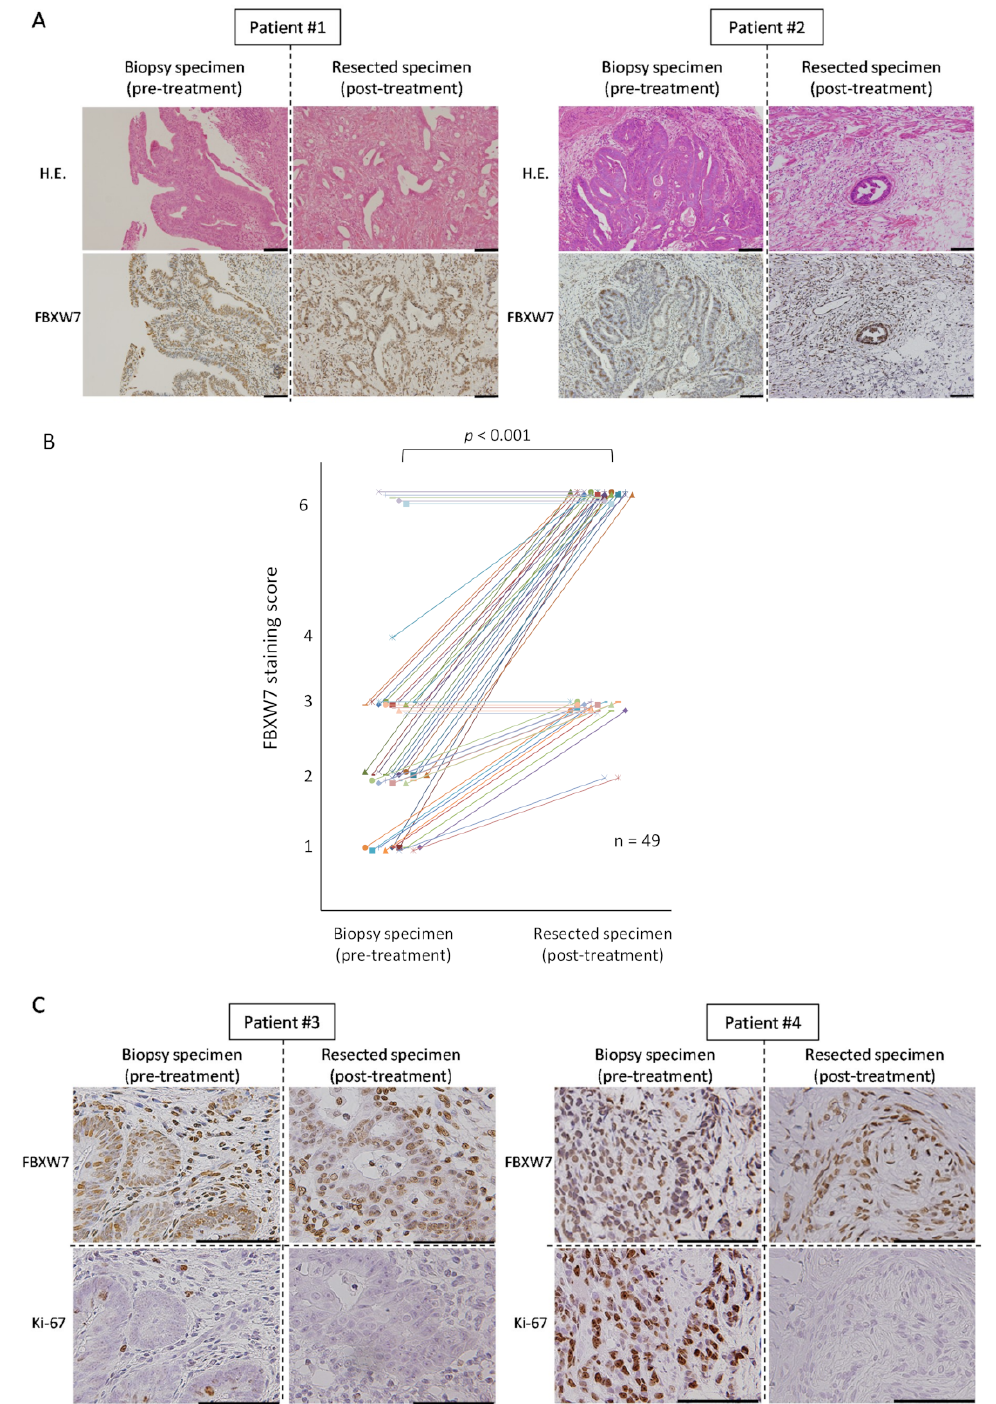
Figure 2. FBXW7 expression in the post-treatment resected specimens is higher than that in the pre-treatment biopsy specimens. ( A ) Hematoxylin and eosin (H.E.) and IHC staining for FBXW7 in serial sections of representative CRC specimens. Patient #1 belongs to the FBXW7-high group and shows low pathological therapeutic e ff ect. Patient #2 belongs to the FBXW7-low group and shows high pathological therapeutic e ff ect. Scale bars, 100 µ m. ( B ) Comparison of FBXW7 staining score between pre-treatment biopsy specimens and post-treatment resected specimens. We evaluated 49 cases in which FBXW7 IHC staining could be performed on both biopsy and surgically resected specimens. ( C ) IHC staining for FBXW7 and Ki-67 in serial sections of representative CRC specimens. Patient #3 belongs to the FBXW7-high group and shows low pathological therapeutic e ff ect. Patient #4 belongs to the FBXW7-low group and shows high pathological therapeutic e ff ect. Scale bars, 100 µ